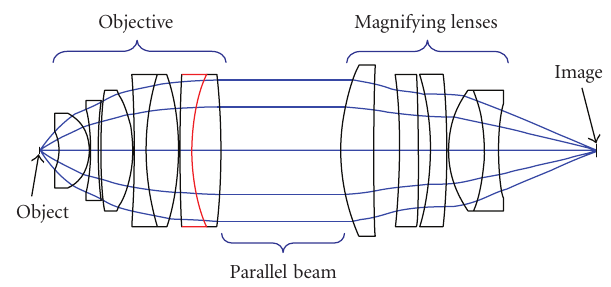
Figure 1: The main optical structure design of the confocal system.